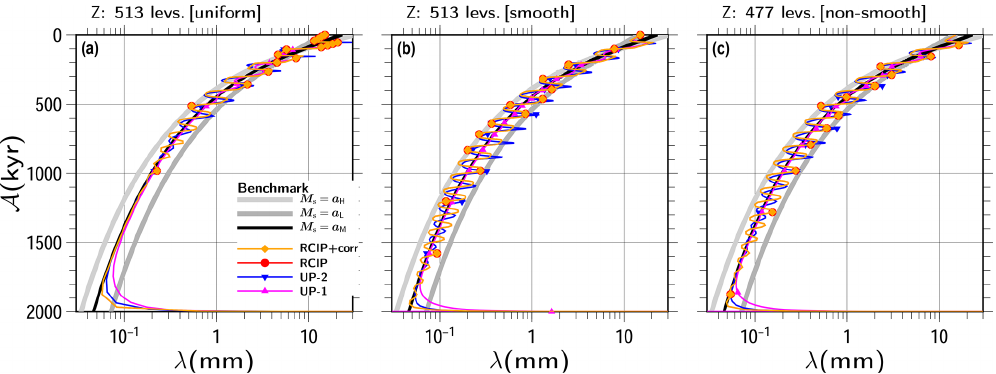
Figure 19. Same as Fig. 10 except for the vertical resolution as (a) uniform grid spacing of 513 levels, (b) smooth non-uniform grid spacing of 513 levels, and (c) non-smooth non-uniform grid spacing of 477 levels. The results at 2000kyr are